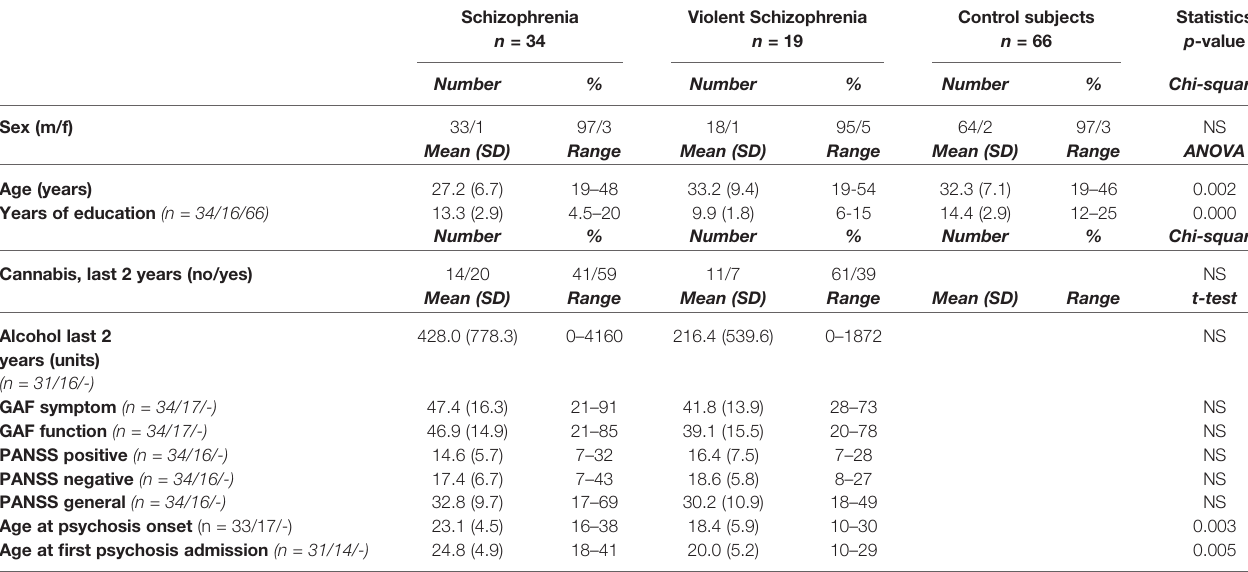
TABLE 1 | Demographic and clinical characteristics.